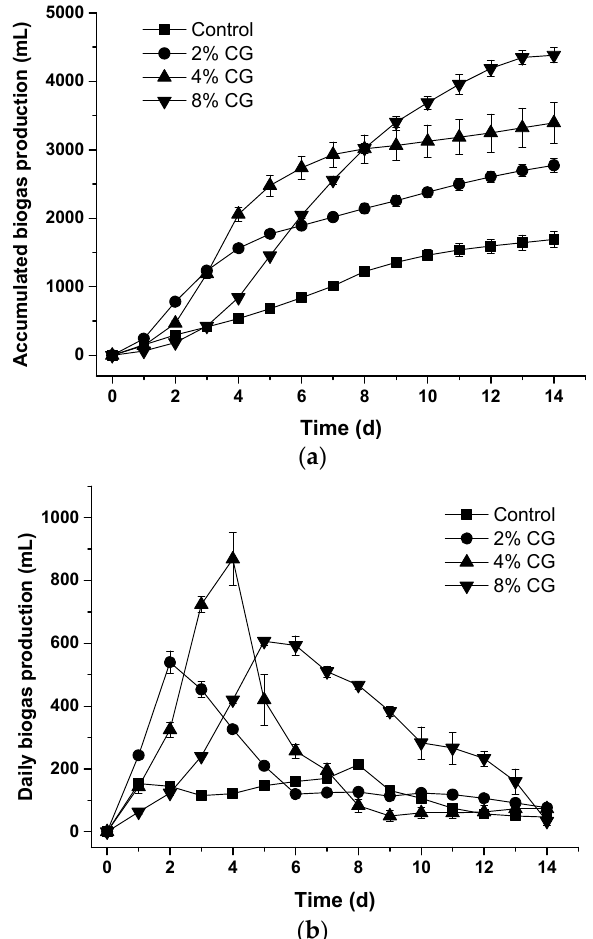
Figure 2. Effects of adding different percentage of crude glycerol on ( a ) daily biogas production and Figure 2. E ff ects of adding di ff erent percentage of crude glycerol on ( a ) daily biogas production and ( b ) accumulated biogas production. ( b ) accumulated biogas production.